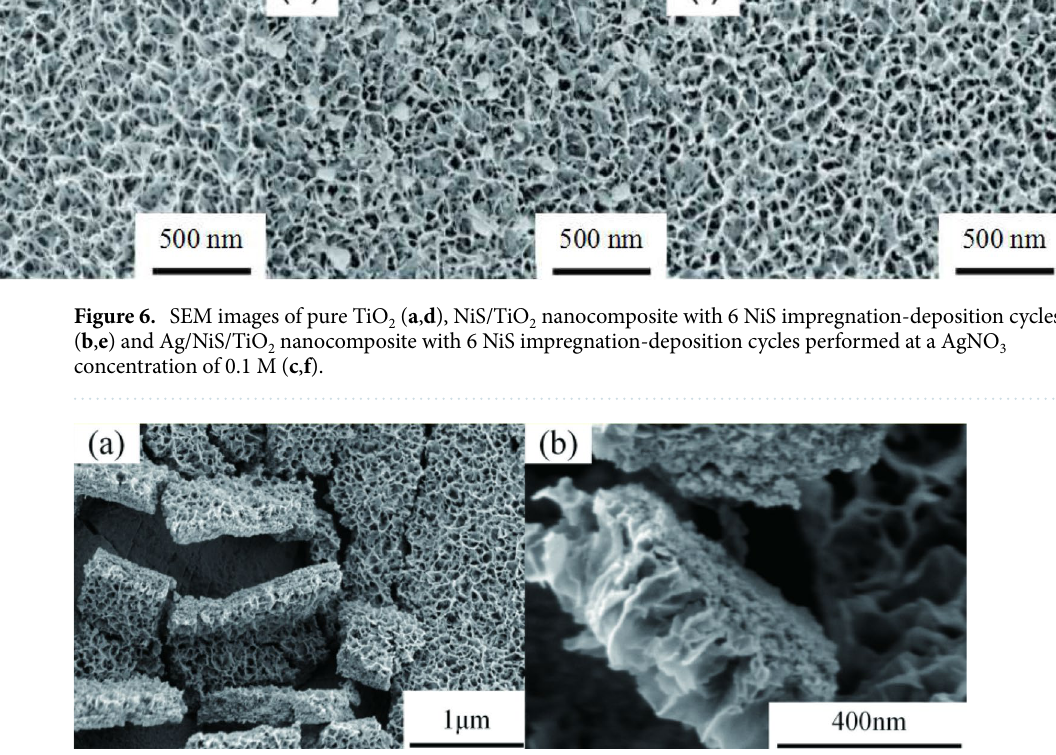
Figure 7. Cross-section of Ag/NiS/TiO 2 nanofilms with 6 NiS impregnation-deposition cycles performed at a AgNO 3 concentration of 0.1